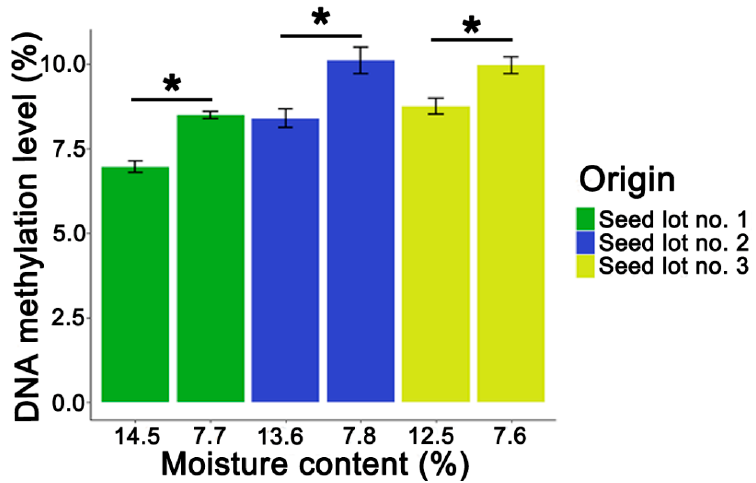
Figure 2. Global 5-methylcytosine level in non-stored non-desiccated and desiccated Populus nigra L. seed lots. Statistical analysis was conducted using the Wilcoxon–Mann–Whitney test. Separate at p < 0.05. Data represent mean ± SE, n = 4.